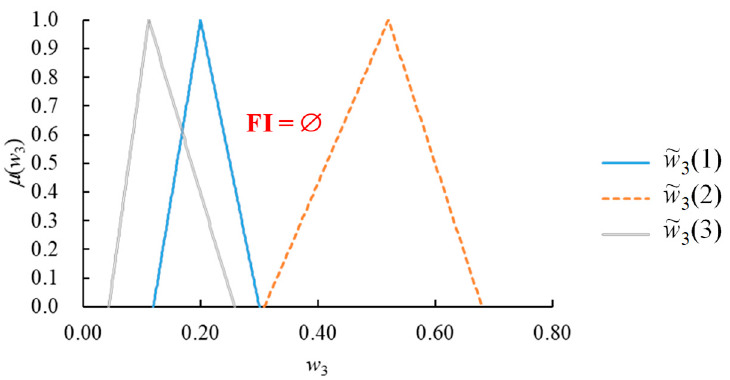
Figure 8. The FI Figure 8. The FI result. Figure 8. The FI result.